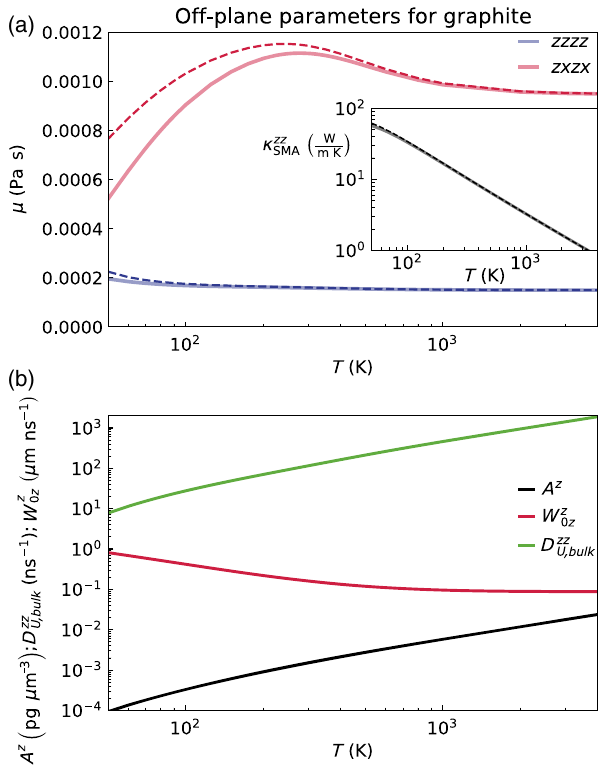
FIG. 9. (a) Off-plane thermal viscosity and off-plane SMA thermal conductivity (inset) of graphite for a sample having a grain size of 10 μ m (solid line) or for the bulk case (dashed line). The other components of the viscosity tensor involving off-plane directions are negligible (at least one order of magnitude smaller than the largest component reported here). (b) Specific momen- tum A z , component W z 0 of the velocity tensor, and component z D zz of the momentum dissipation tensor of U; bulk